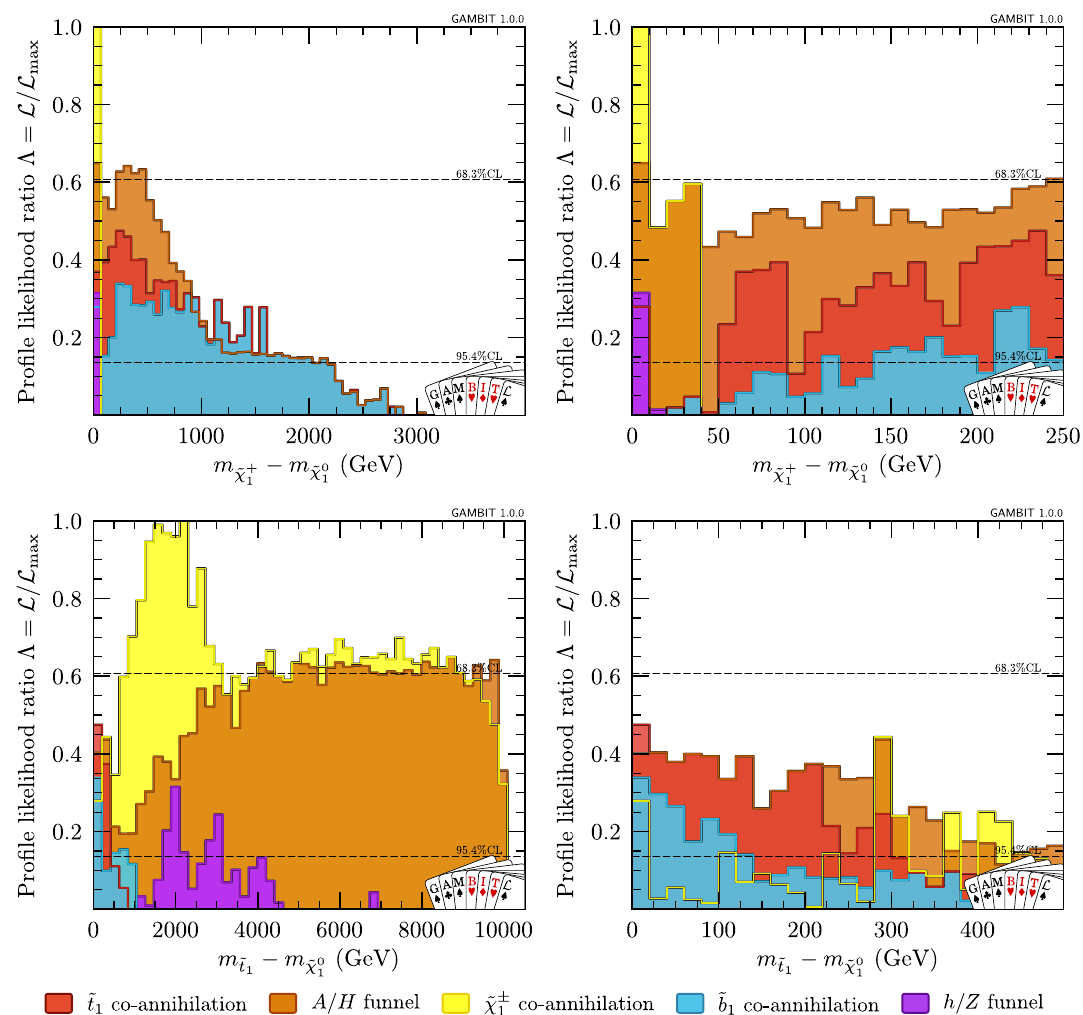
− ˜ χ 0 Fig. 9 1D profile likelihood ratios for the ˜ χ ± charginos,stopsorsbottoms,andresonantannihilationthroughthelight mass difference 1 1 or heavy Higgs funnels. Right: as per the left, but zoomed in to small mass difference (bottom). Left: separate distri- (top) and the ˜ t 1 − ˜ χ 0 1 mass butions for each mechanism allowing models to obey the relic density constraint. The regions correspond to neutralino co-annihilation with